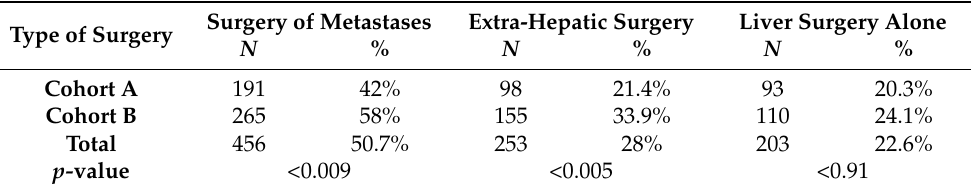
Table 2. Liver surgery vs. surgery of other sites.